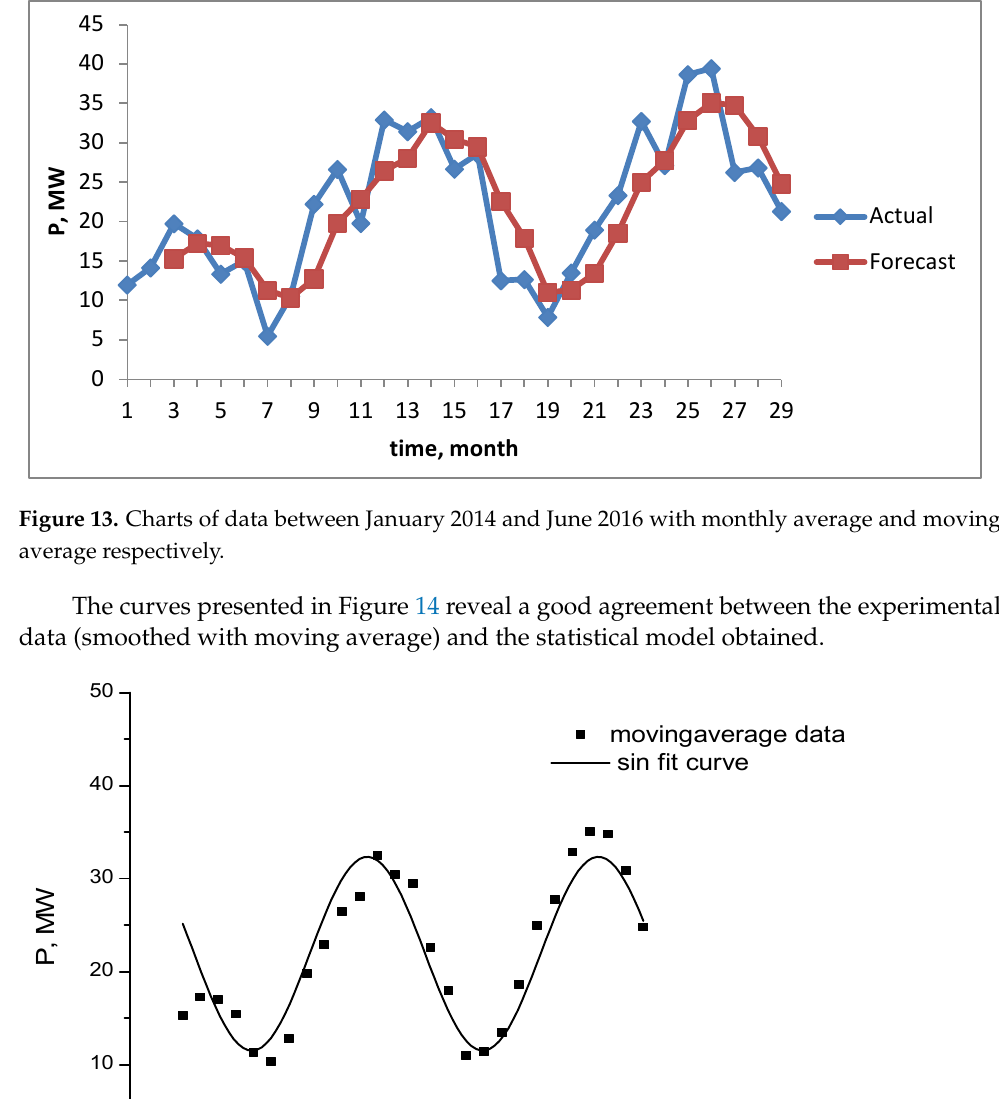
Figure 13. Charts of data between January 2014 and June 2016 with monthly average and moving average respectively